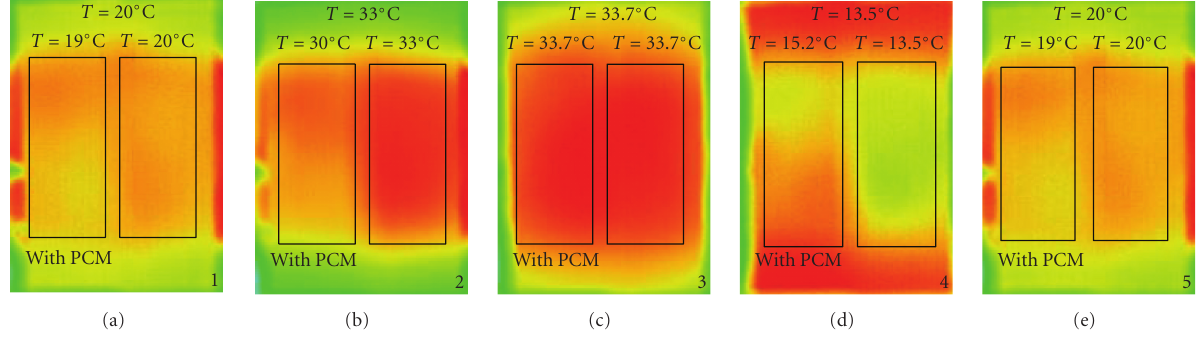
Figure 5: Colour images of soy resin measured by infrared